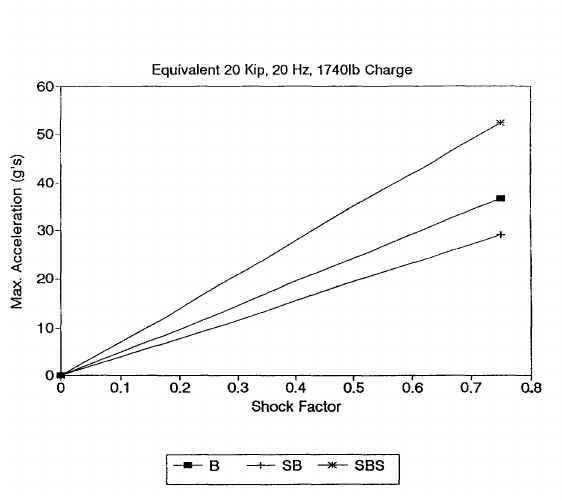
FIGURE 11 Least squares response slopes for models B, SB, and